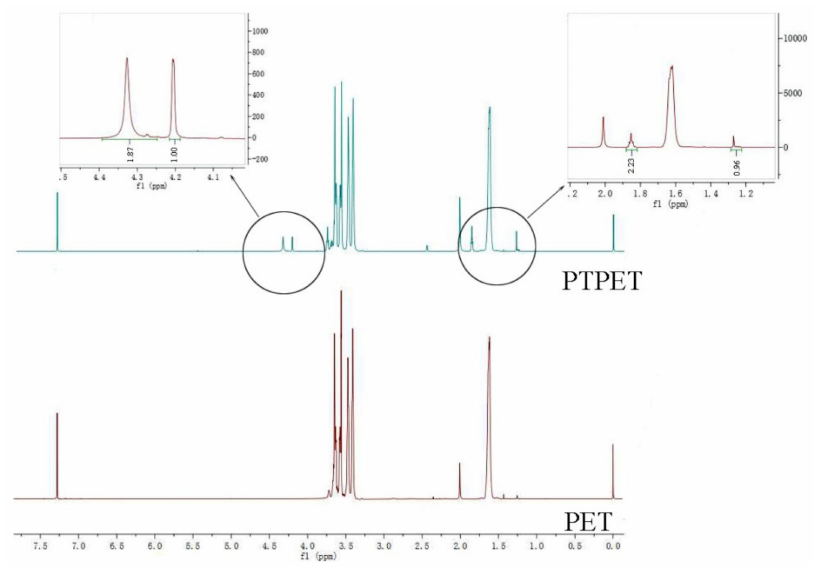
Figure 2. 1 H NMR spectra of PET and